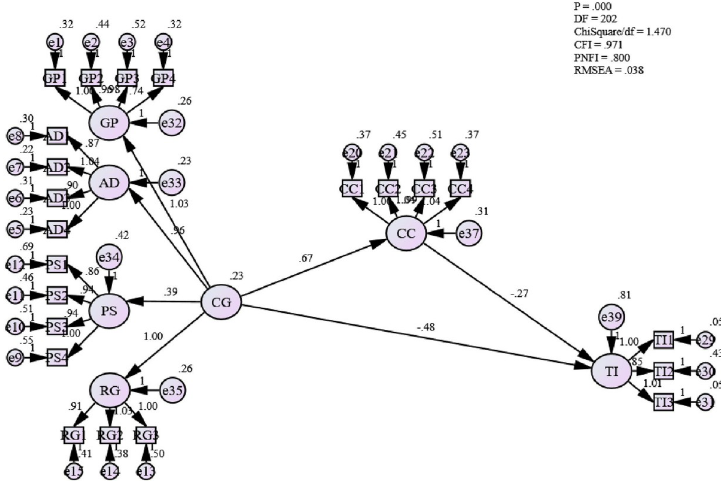
Fig 10. Mediating effect of continuance commitment between career growth and turnover intentions.